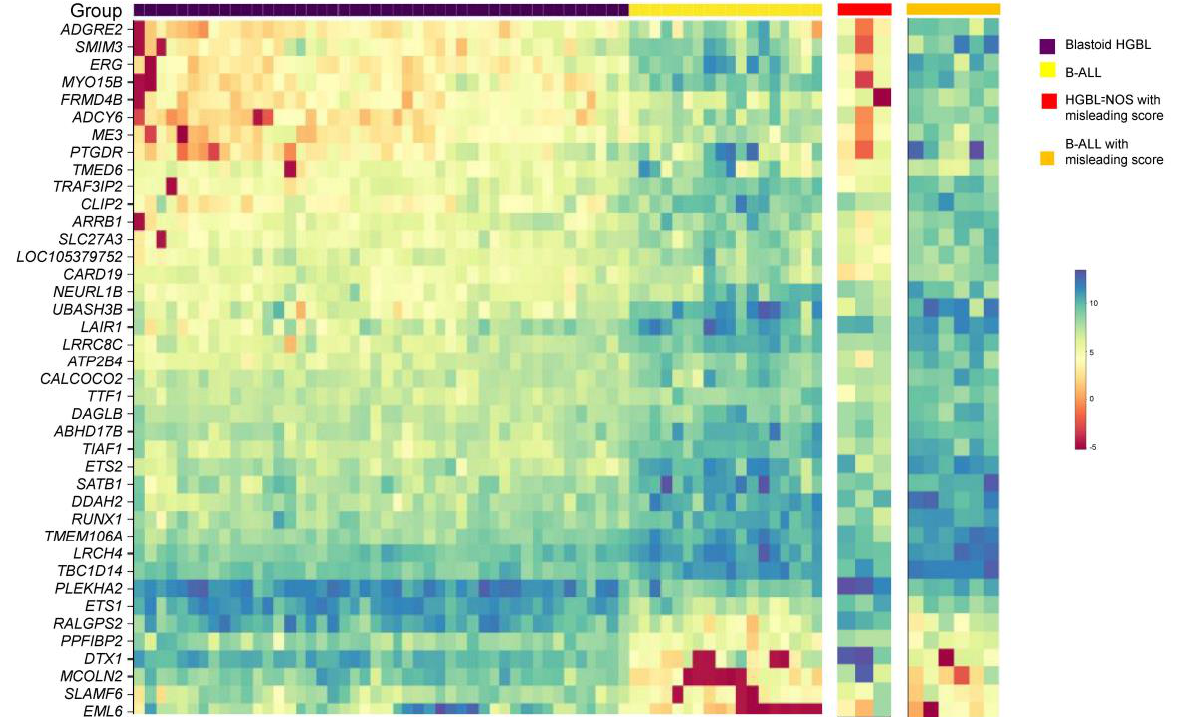
Figure 3. Transcriptome profiling confirmed the correct diagnosis of cases with misleading scores. Heatmap of the top 40 differentially expressed genes for blastoid HGBL in comparison with B-ALL. The 3 cases of blastoid HGBL and 6 cases of B-ALL with misleading scores showed a gene expression profile similar to blastoid HGBL and B-ALL,